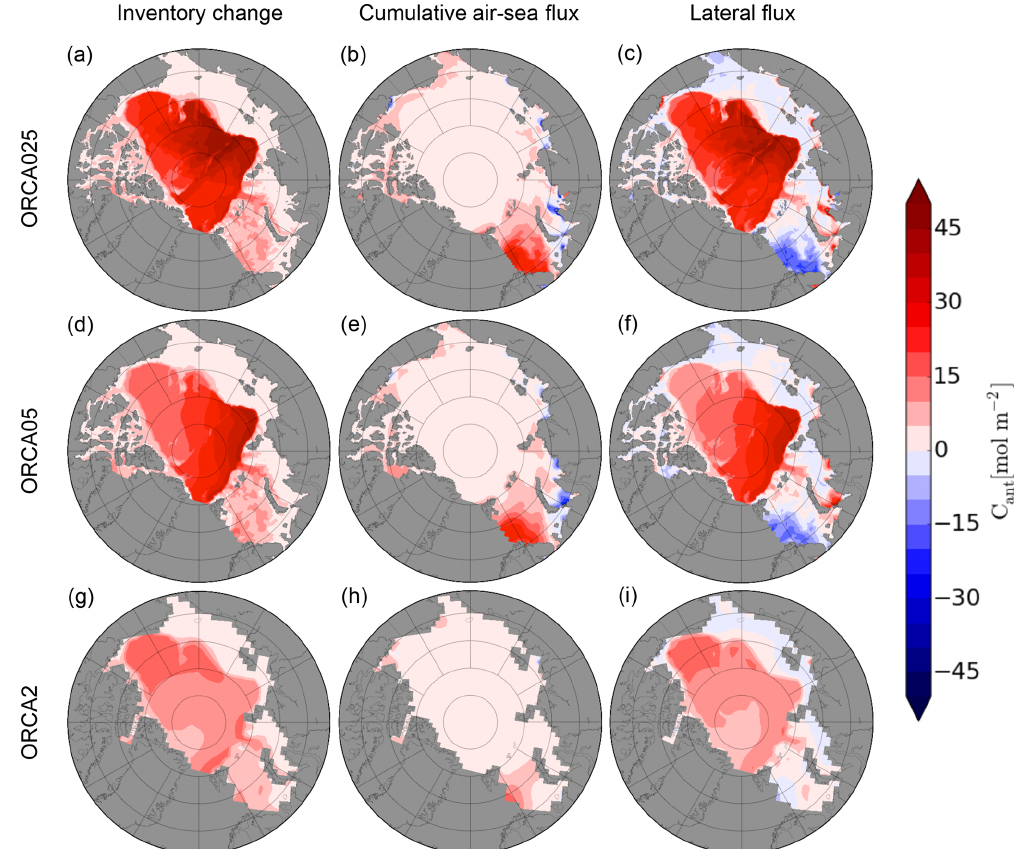
Figure 8. Inventory change (a, d, g) , cumulative air–sea flux (b, e, h) , and the lateral flux calculated as the inventory change minus the cumulative air–sea flux (c, f, i) of C ant over 1960–2012 for ORCA025 (a–c) , ORCA05 (d–f) , and ORCA2 (g–i) .